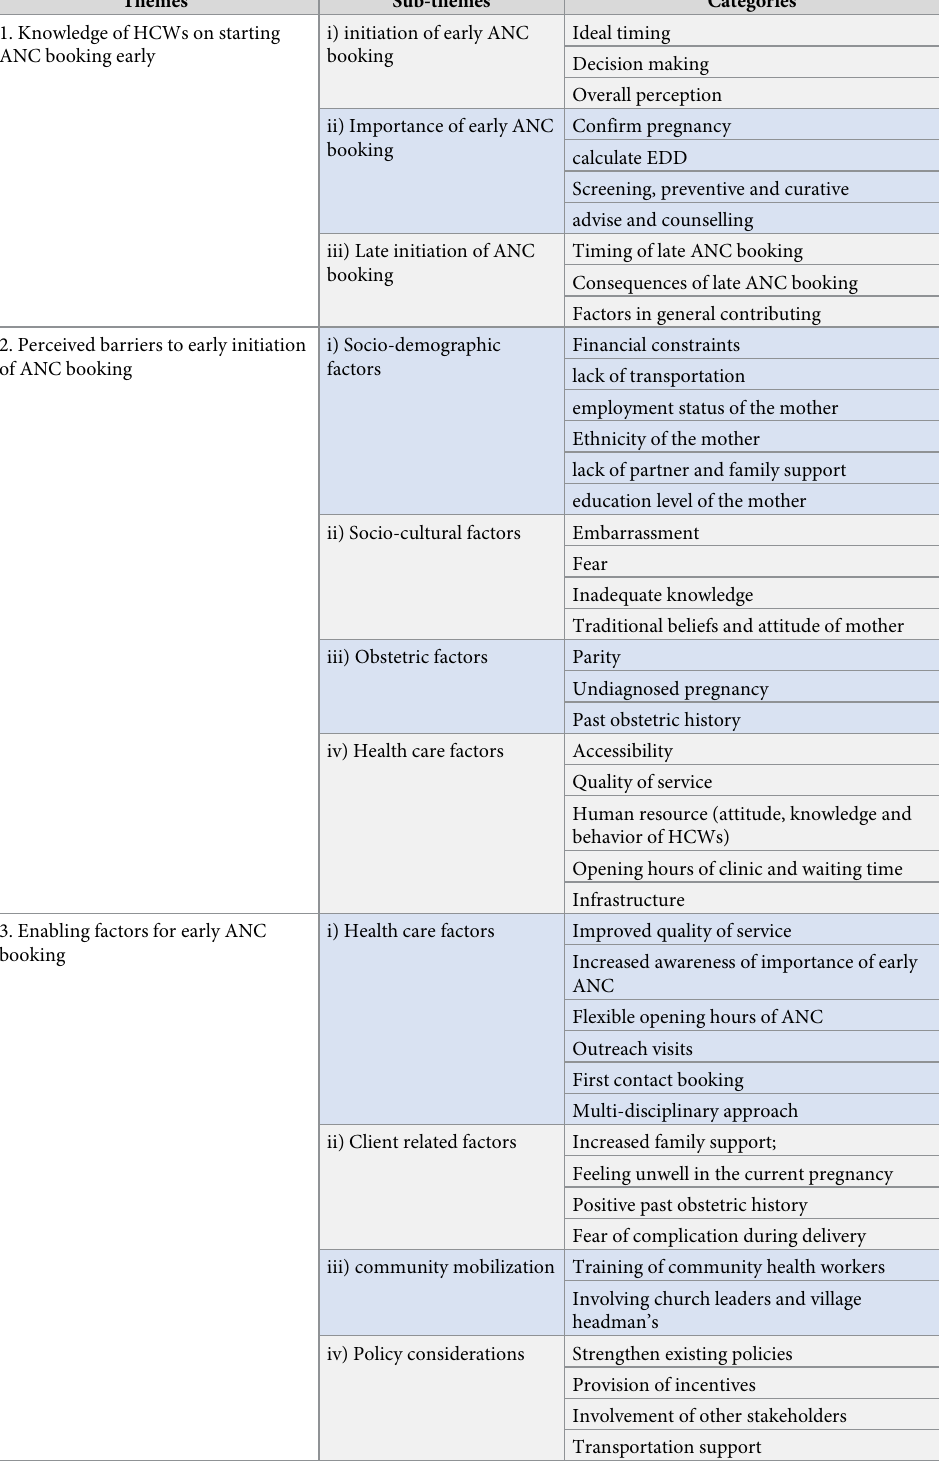
Table 2. Themes and sub themes of the FGDs with the